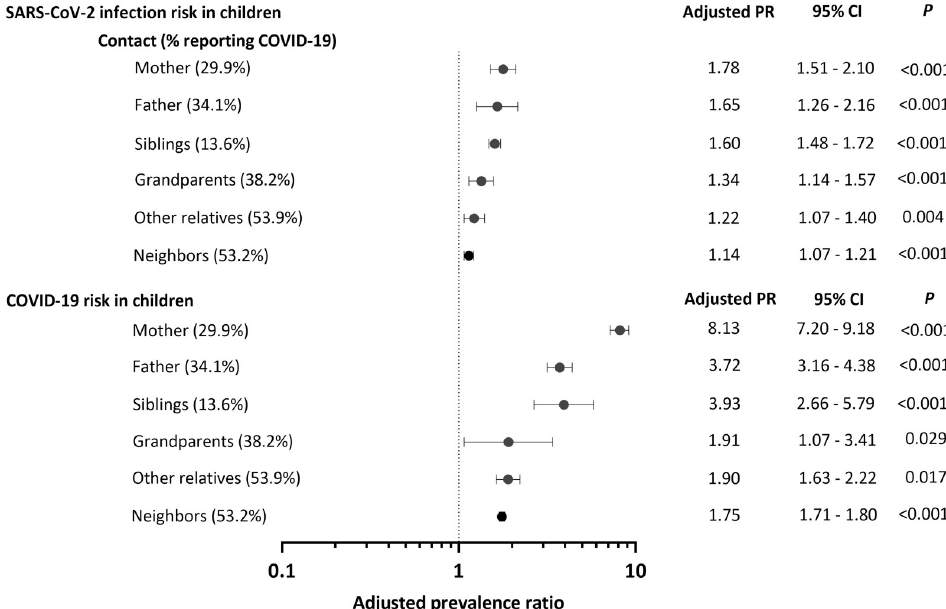
Fig 3. Association between self-reported prior COVID-19 in household and family contacts (close relatives or neighbors) and the risk of SARS-CoV-2 infection and clinically apparent COVID-19 in 5 years-old Amazonian children. Adjusted prevalence ratios (PR) indicate the magnitude of association between exposure to COVID- 19-reporting household or family contacts and two outcomes, SARS-CoV-2 seropositivity and COVID-19, among MINA-Brazil study participants (n = 660), after controlling for the following potential confounders: child 0 s age, mother 0 s self-reported skin color and schooling, and household wealth index tercile for SARS-CoV-2 seropositivity; and child 0 s age, mother 0 s self-reported skin color and schooling, and presence of household food insecurity for clinically manifest COVID-19. Note that the denominators (numbers of children at risk) are the same in analyses with different outcomes (SARS-CoV-2 infection in the upper panel and clinically apparent COVID-19 in the lower panel). PR estimates and their respective 95% confidence intervals (95% CIs) and P values were derived from separate multiple mixed-effects Poisson regression models which each child contact type tested at once as an explanatory variable.